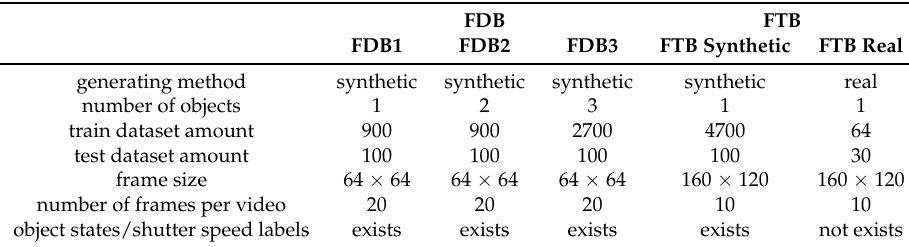
Table 1. Dataset